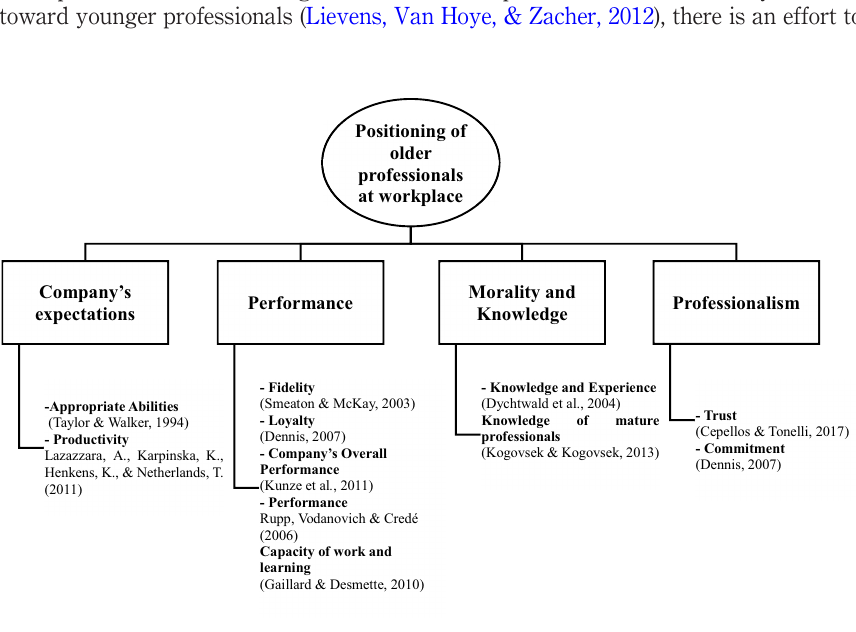
Figure 1. Constructs related to the positioning of professionals aged 50 and over